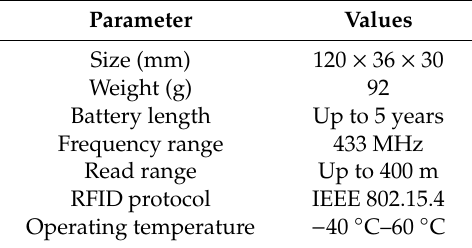
Table 3. The properties of the active RFID